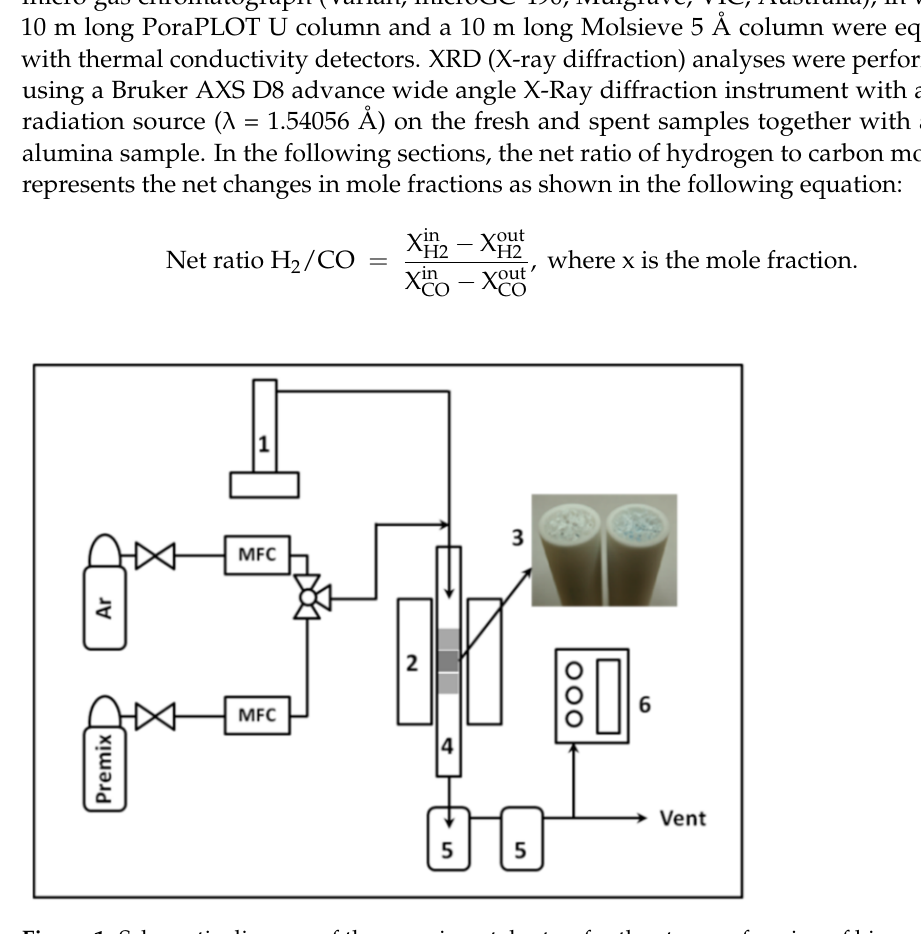
Figure 1. Schematic diagram of the experimental setup for the steam reforming of bio-syngas: ( 1 ) water pump, ( 2 ) electric furnace, ( 3 ) Rh loaded alumina catalyst, ( 4 ) SiC reactor, ( 5 ) cold traps and ( 6 ) a micro-GC.